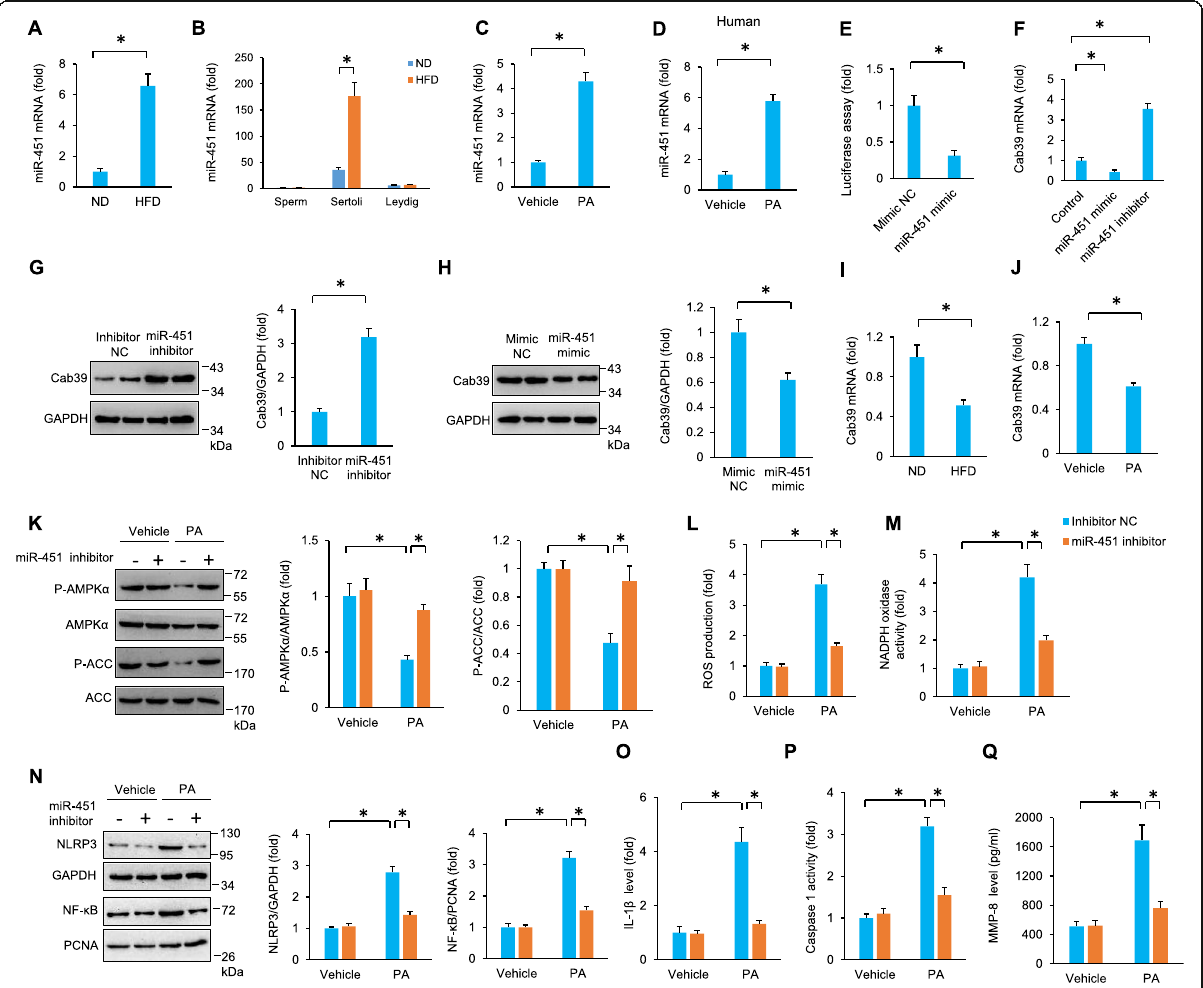
The miR-451 level in PA-treated mouse and human primary SCs ( n = 6). E The luciferase assay in cultured TM4 cells ( n = 6). F – J Cab mRNA and protein expression in cultured TM4 cells ( n = 6). K The protein expression of AMPK α and ACC in PA-treated TM4 cells at 24 h after miR-451 inhibition ( n = 6). L , M ROS production and NADPH oxidase activity in PA-treated TM4 cells at 24 h after miR-451 inhibition ( n = 6). N The protein expression of NLRP3 and NF- κ B in PA-treated TM4 cells at 24 h after miR-451 inhibition ( n = 6). O – Q The IL-1 β level, caspase 1 activity and